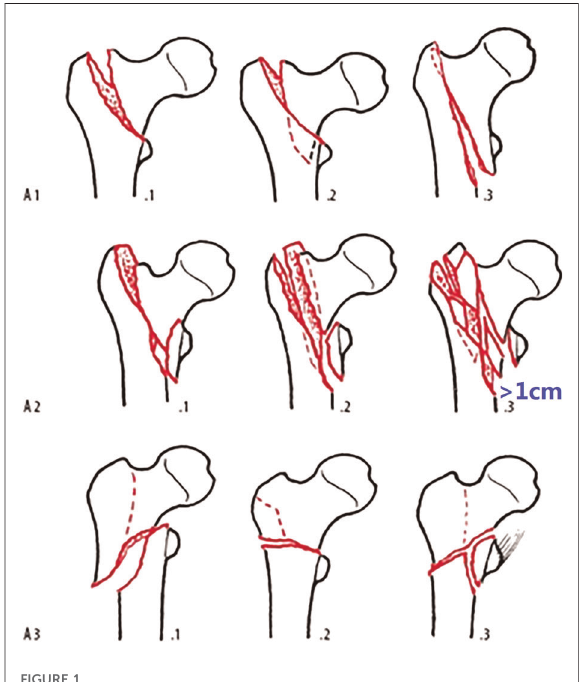
FIGURE 1 AO/OTA fracture classi fi cation of proximal femur trochanteric region 31A, 1996/2007 version.